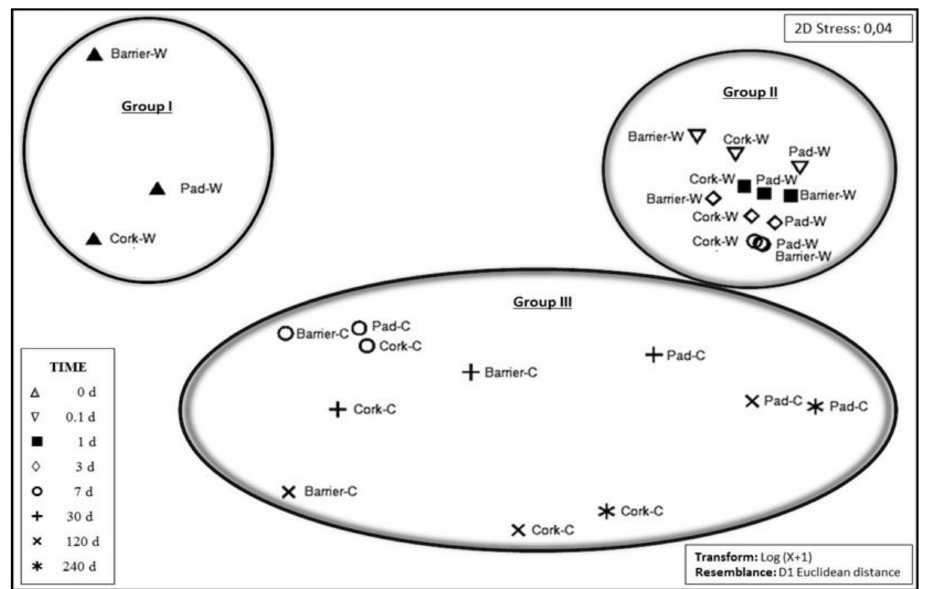
Figure 7. Optimal two dimensional configurations computed by multidimensional scaling (MDS) correlation of the water samples from the bioreactors and support material samples from each treatment.